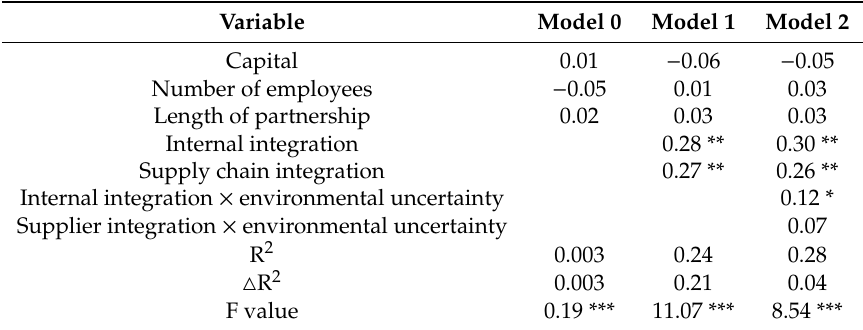
Table 4. Supply chain integration and relationship stability with suppliers.